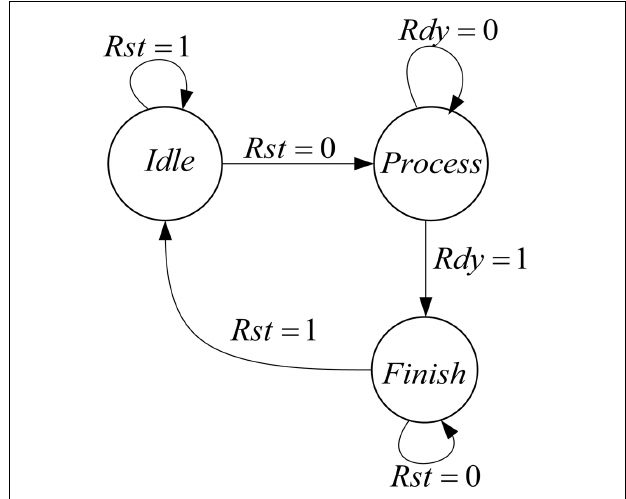
FIGURE 6 | Designed controller for the implemented mini-column.